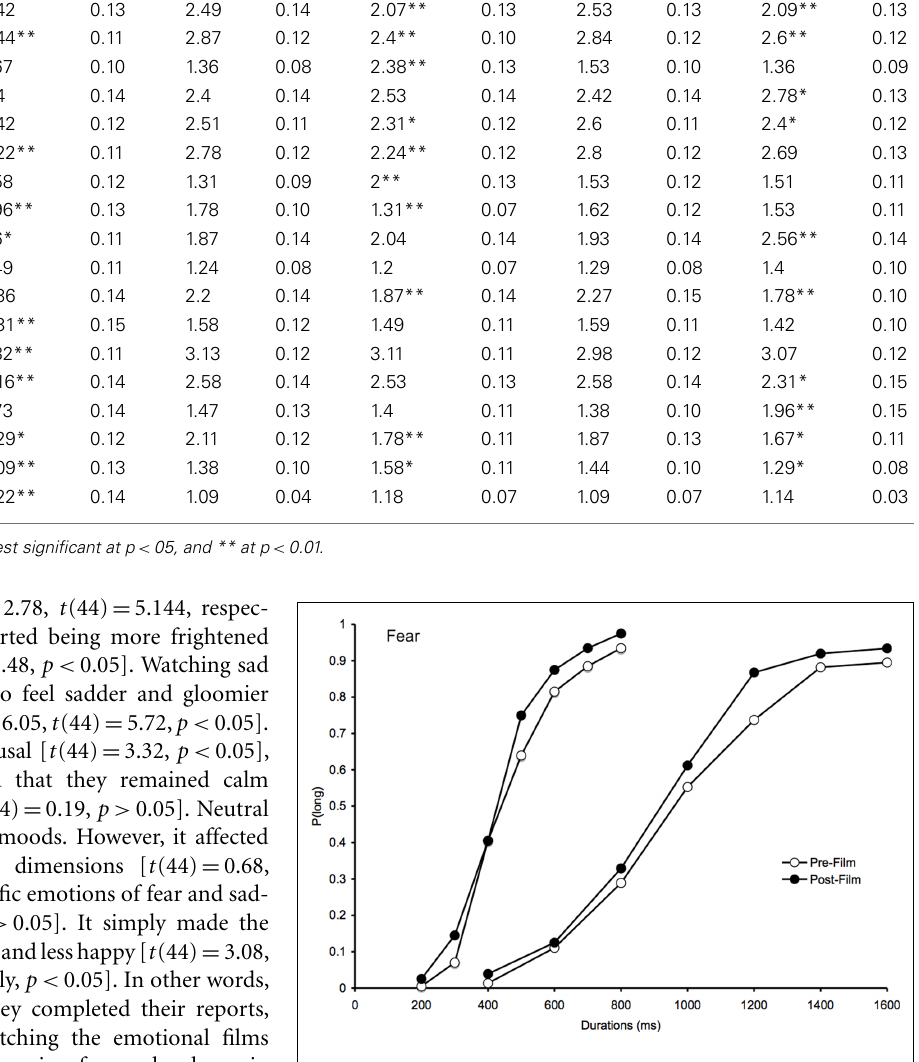
FIGURE 1 | Psychometric function for fear. Proportion of long responses plotted against probe durations (ms) for the bisection task before and after viewing the frightening films in the 200/400 and the 800/1600-ms duration